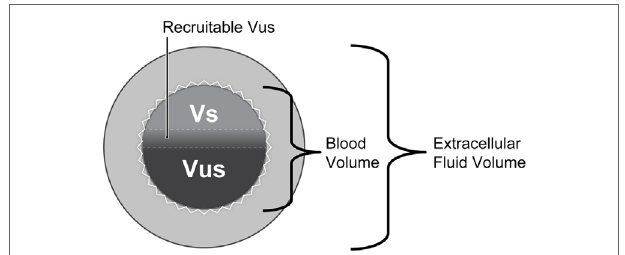
Figure 2 | The total blood volume within the vasculature can be divided into two components: stressed circulating blood volume (Vs: approximately 30% of the blood volume) and unstressed intravascular volume (Vus: approximately 70% of the blood volume). The Vs is hemodynamically active (i.e., effective circulating blood volume) and is the principal determinant of the mean systemic pressure, a primary determinant of venous return. The Vus is the volume of blood required to fill the vascular space without increasing blood pressure. A portion of the Vus (up to 15–20 mL/kg; shaded area between the dashed horizontal lines) serves as a blood reservoir and can be recruited to augment the Vs during times of stress or replenish the Vs during hypovolemia. The wavy white line surrounding the inner circle (i.e., volume) suggests that the volume contained therein can become smaller or larger depending upon changes in vasomotor